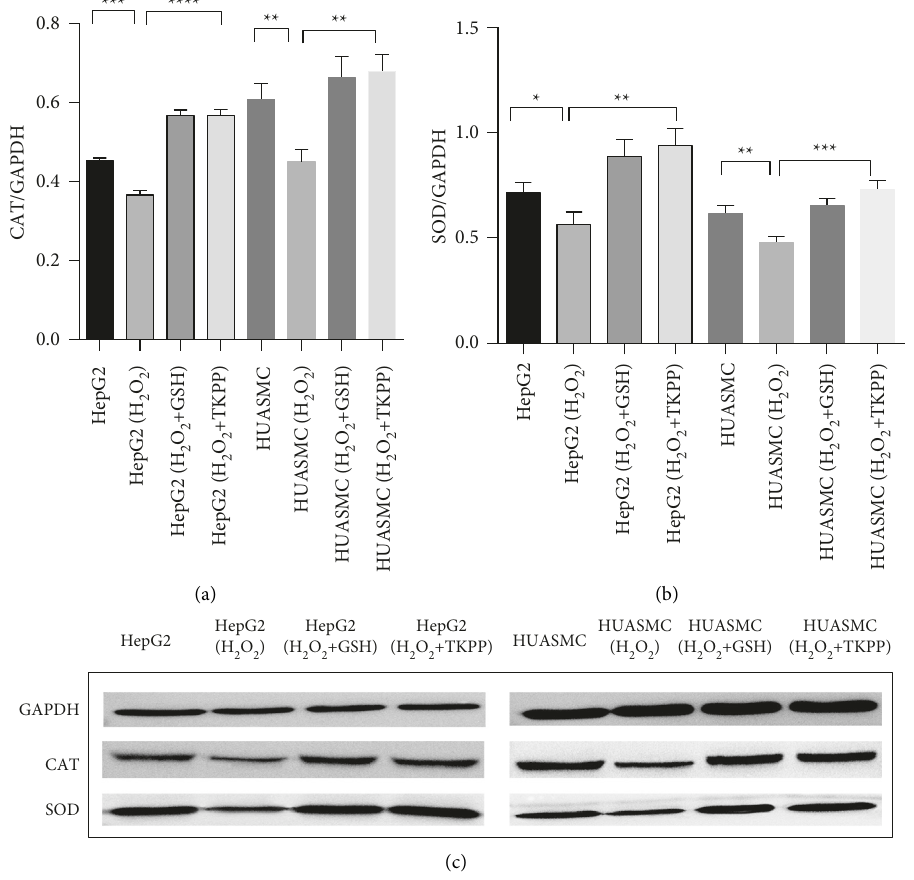
Figure 4: Protein expression detection of CAT and SOD in TKPP group. (a) Band intensity of CAT protein expressions in each group. (b) Band intensity of SOD protein expressions in each group. (c) Immunoblotting of CAT and SOD proteins in each group. ∗ P < 0 . 05, ∗∗ P < 0 . 01, ∗∗∗ P < 0 . 001, and ∗∗∗∗ P < 0 .